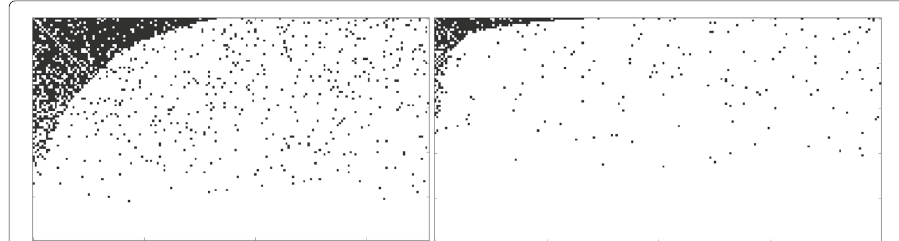
Fig. 5 Examples of adjacency matrices of benchmark graph for n a / n b = 1.5 (left panel) and n a / n b = 3 (right panel) with addition one-dimensional random rewiring ρ rew = 0.5. Due to the larger space for the right-hand plot the density is lower although the random rewiring has the same